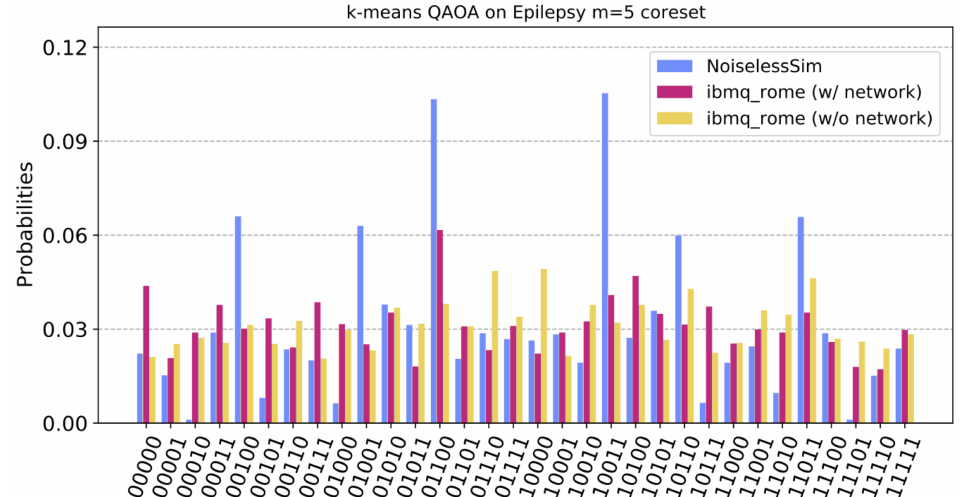
Figure 5. An experimental evaluation of a QAOA circuit implemented with and without the swap network [33,34]. Each distribution consists of 8192 individual shots. The noisy execution of the quantum hardware becomes apparent when comparing the experimental results with the noiseless simulation. However, by utilizing the swap network, one of the optimal bitstrings (01100) can still be identified in the output distribution with high